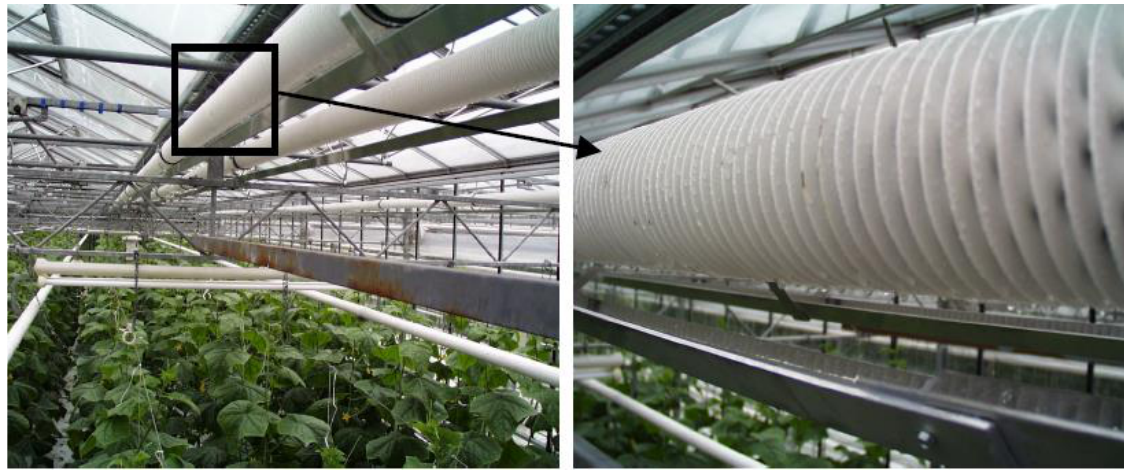
Figure 4. Dehumidification and water recovery system using finned pipes [75]. Table 3. VPD requirements (at 25 ◦ C) for selected greenhouse crops used in arid regions.